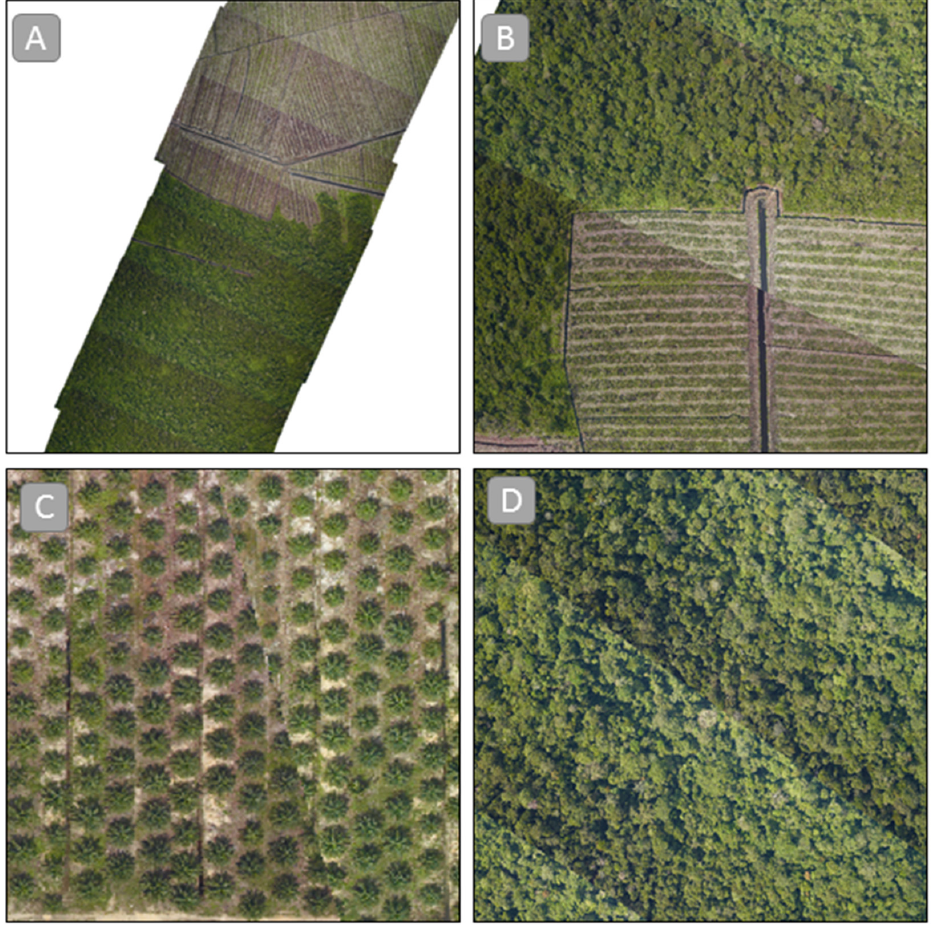
Figure 3. Examples from airborne imagery used to help guide development of polygons for training and validation. ( A ) shows oil palm plantation (top) and natural forest (bottom); ( B ) shows oil palm plantation (bottom right) and natural forest (top) highlighting natural forest canopy variability; ( C ) shows oil palm stand with structured planting and cleared ground; ( D ) shows representative natural forest canopy.